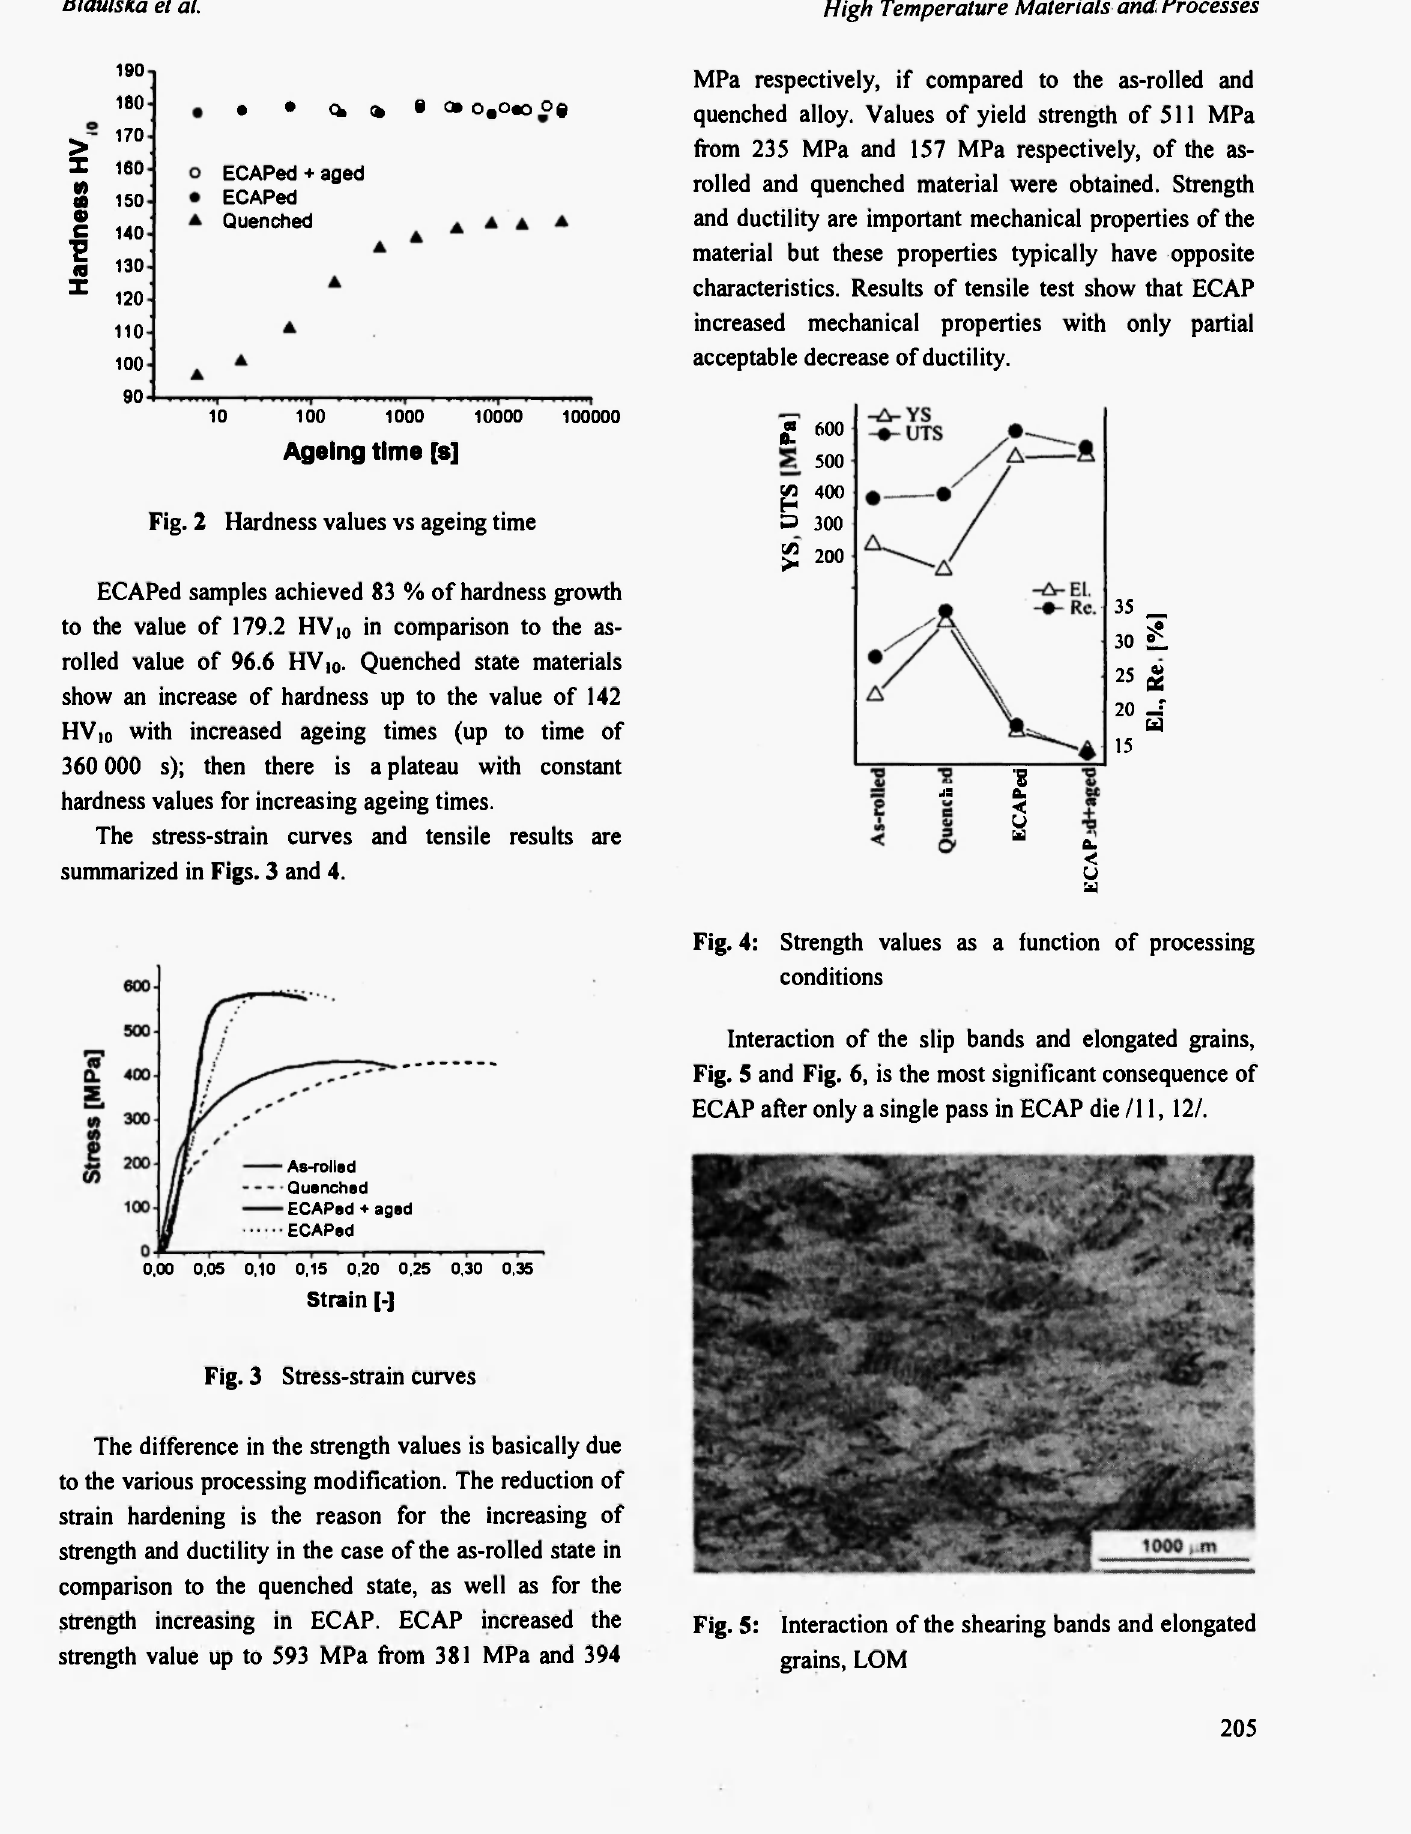
Fig. 5: Interaction of the shearing bands and elongated grains,